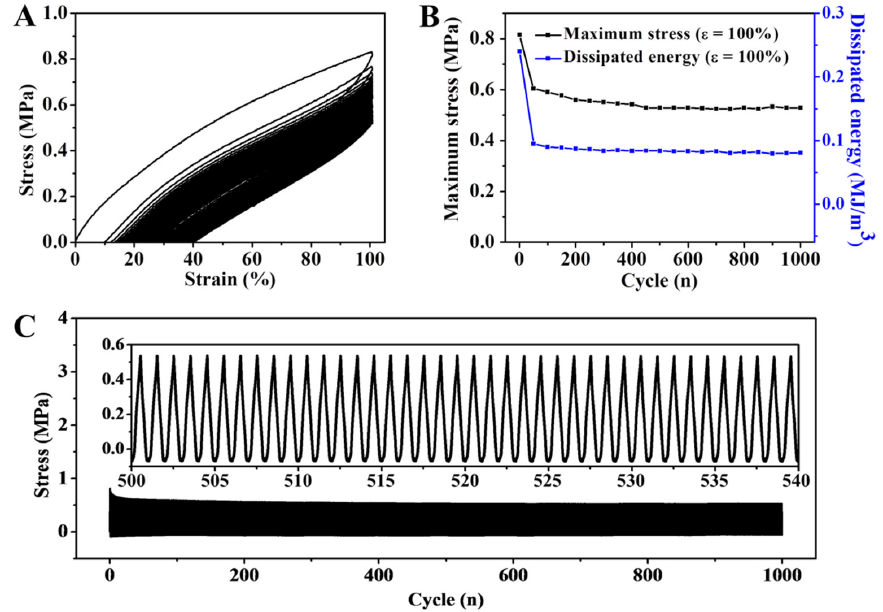
Figure 5. ( A ) 1000 continuous elongation–relaxation cycles of the DN hydrogel. ( B ) The evolution of maximal stress and dissipated energy during 1000 cycles. ( C ) Real-time stress curve during a continuous 1000 cycles at a strain of 100%. The built-in figure was the stress curve during the 500th to 540th cycles.